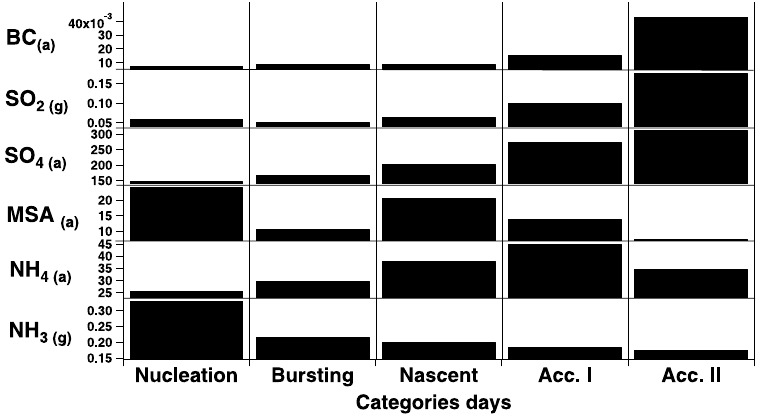
Figure 3. Average daily concentrations of selected chemical tracers for each aerosol